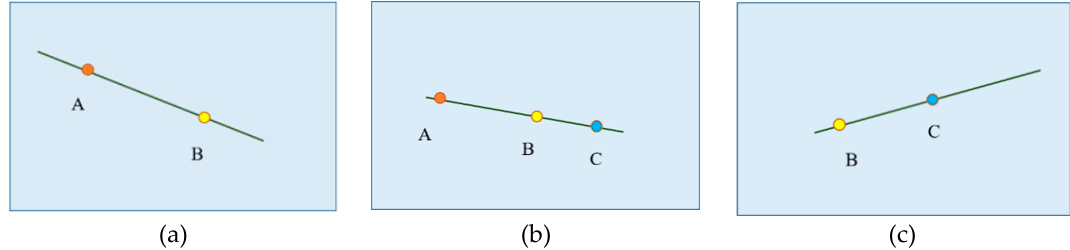
Figure 5. An example of the establishment of a collinear relationship. From the correspondence between lines and points, we can match the line segments in frame 1 ( a ) and frame 2 ( b ), and frame 3 ( c ). In this way, we know all three line segments are parts of the projection of one 3D line, ignoring the shift of endpoints, and all the three points are on this 3D line.